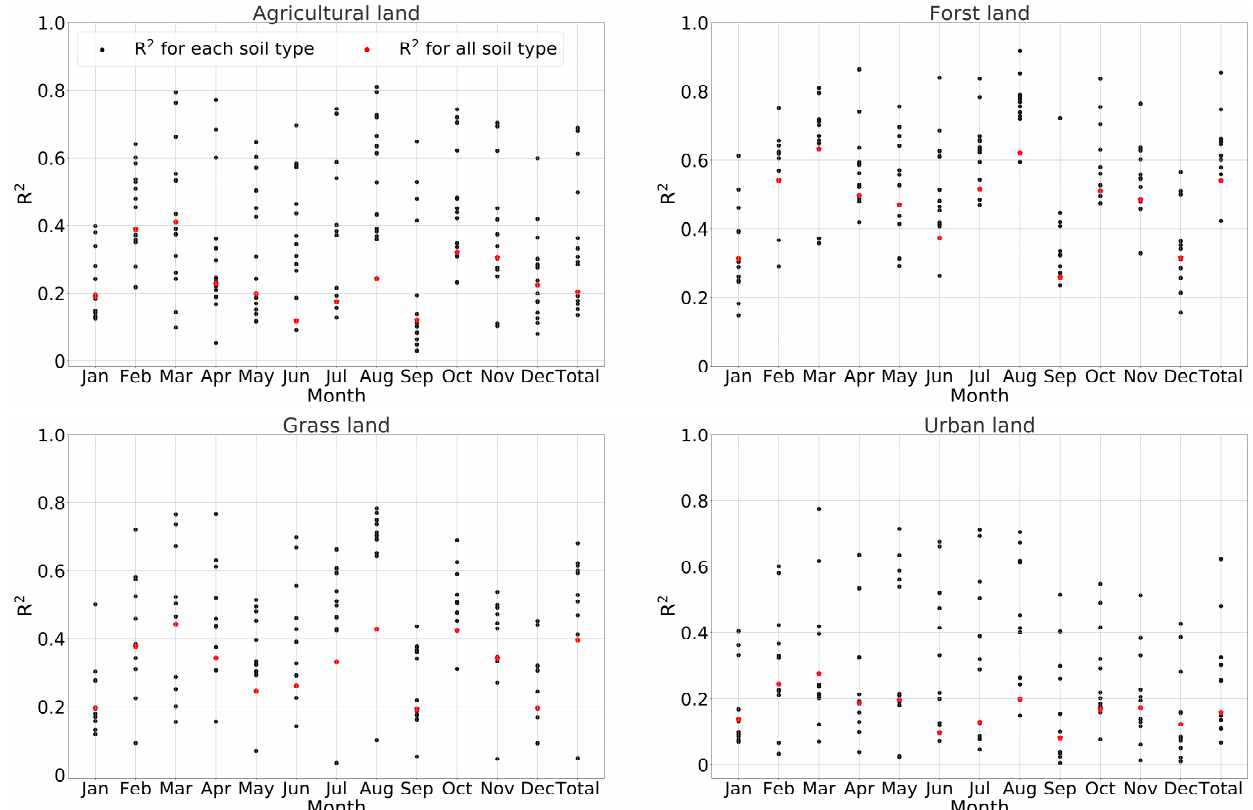
Figure 7. The R 2 of each MLR formulation for different combinations of land use and soil type in different months. The form of the formulation was shown in Table 1. The R 2 for each soil type was the R 2 of the MLR formulation for the HRUs with each different soil type and specific land use type. The R 2 for all soil types was the R 2 of the MLR formulation for the HRUs with all the different soil types and specific land use types. For example, in the first subfigure, the different black points represent the R 2 of the MLR equation established based on the data in the HRUs with a single soil type and agricultural land; while the red points represent the R 2 of the MLR equation established based on the data in the HRUs with all soil type and agricultural land.